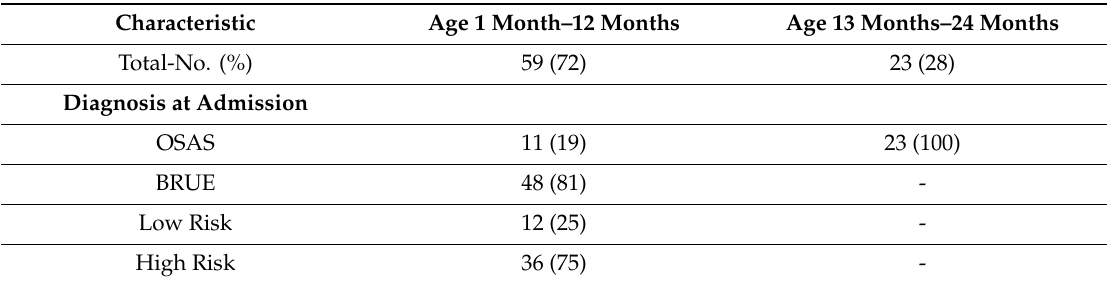
Table 1. Characteristics of the sample based on clinical diagnosis at admission and age.